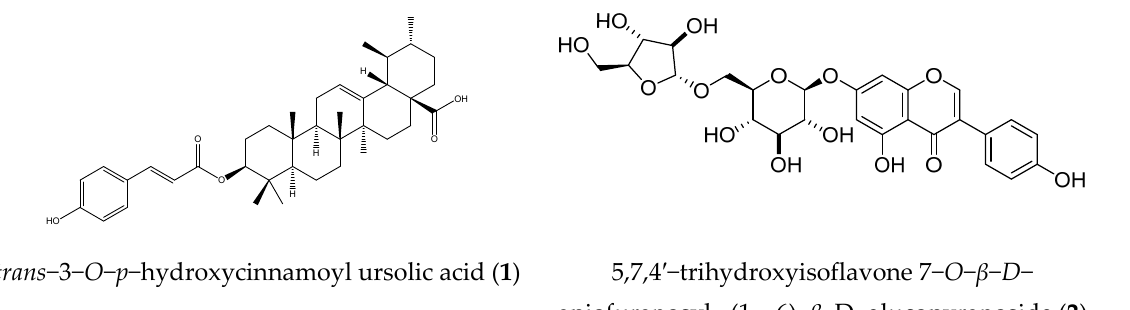
Figure 5. Structures of compounds 1 and 2